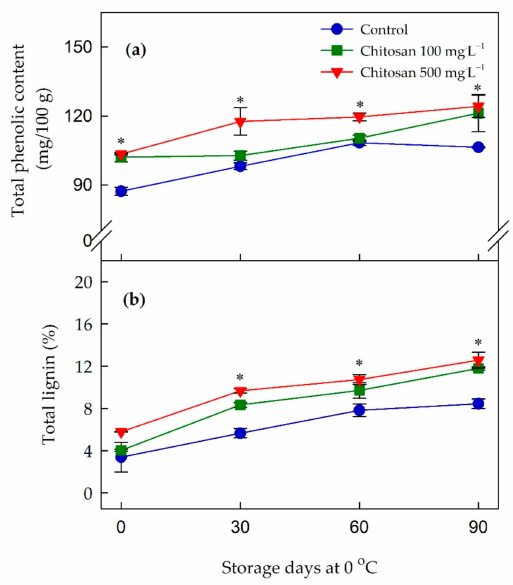
Figure 2. Effects of preharvest chitosan application on ( a ) total phenolic content and ( b ) total lignin content during cold storage in ‘Garmrok’ kiwifruit. Vertical bars indicate SE with n = 3. * indicates significant differences between treatments at each sampling date, according to the least significant difference (LSD) test at p ≤ 0.05.